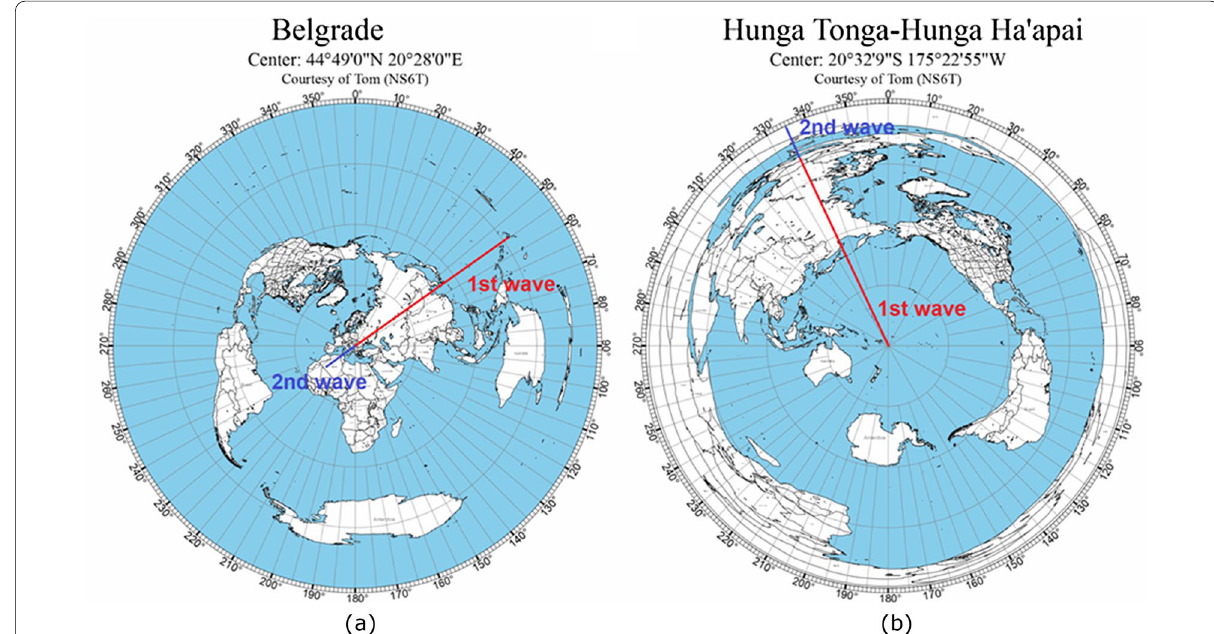
Fig. 6 Azimuthal map with two construction poles: Belgrade ( a ) and HT–HH ( b ). The red line indicates the direction of the first shock wave propagation, and the blue line the direction of the second shock wave